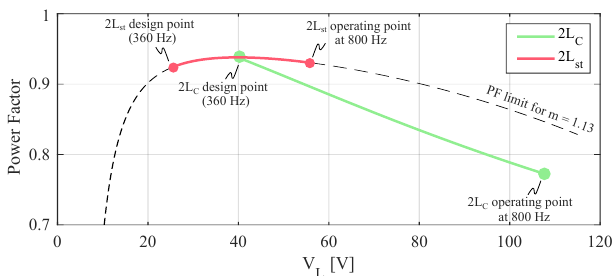
Figure 5. Operating PF of 2L C and 2L st converters at nominal power.